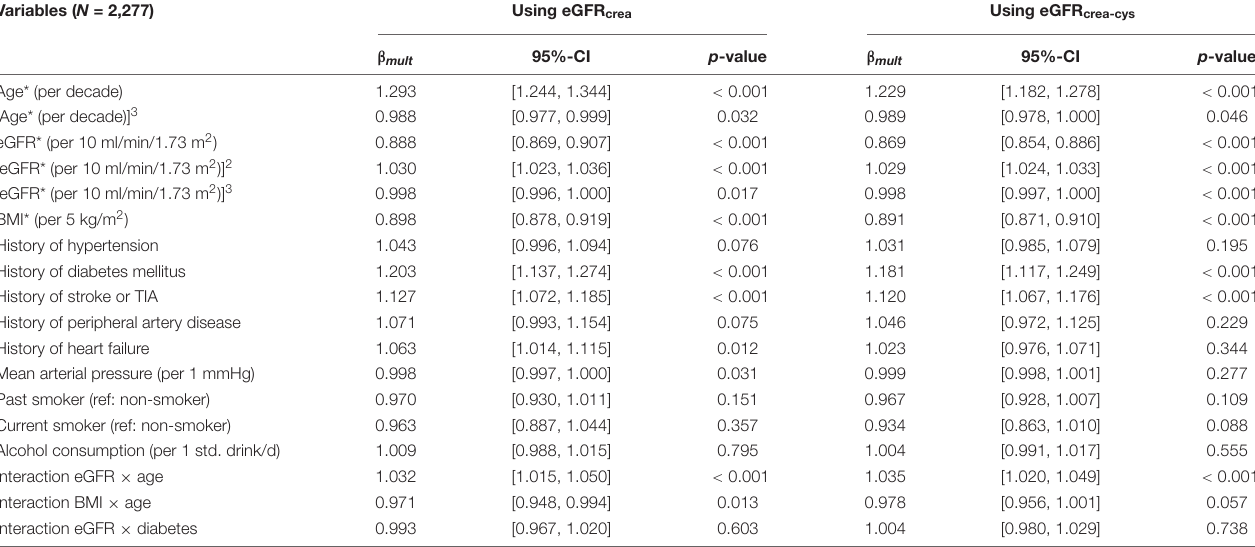
TABLE 2 | Multivariable models for the association of eGFR and BMI with sNfL. Variables ( N = 2,277)